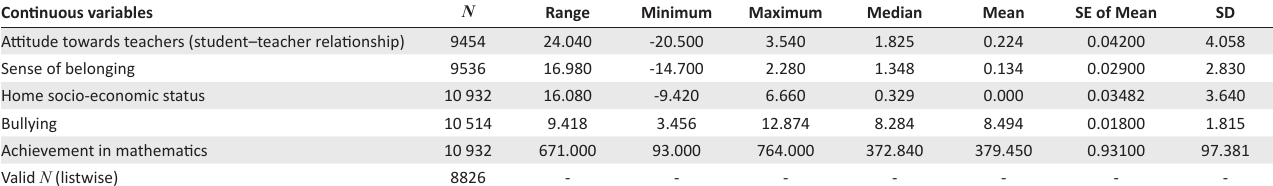
TABLE 1: Descriptive statistics of the selected continuous variables. Continuous